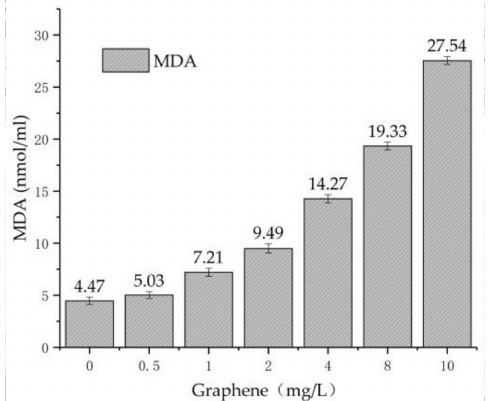
Figure 6. The variation of MDA with graphene